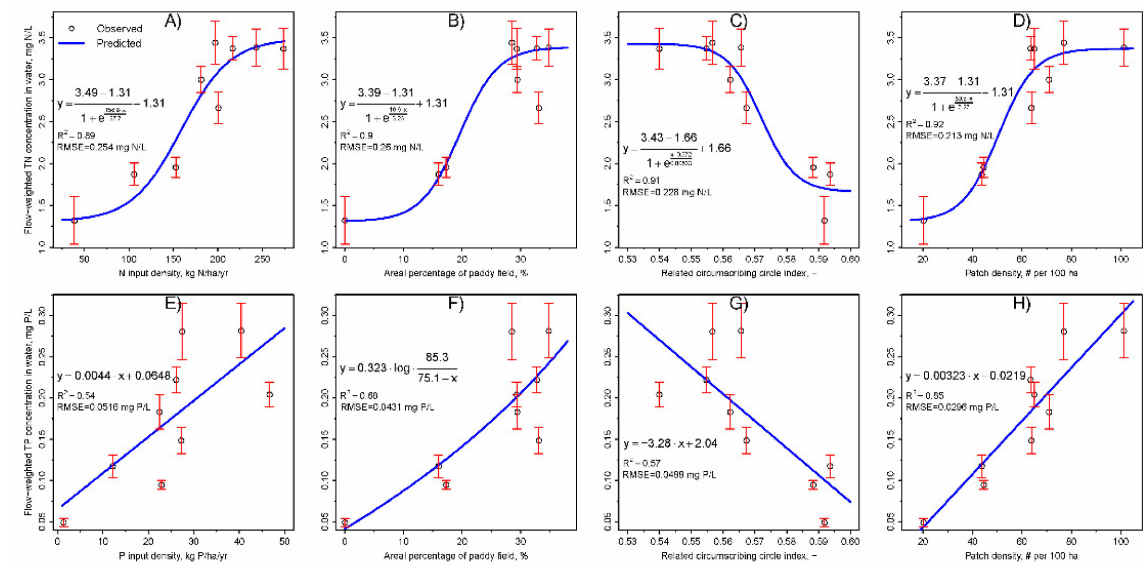
Figure 3. Relationships of the flow-weighted total nitrogen (TN) and total phosphorus (TP) concen- trations in outlet water with the N and P input densities ( A , E ), the areal percentage of paddy field ( B , F ), the related circumscribing index ( C , G ) and the patch density ( D , H ) in the nine catchments. The blue lines are the model fitting curves. The bars denote the standard errors of the observed 6-year flow-weighted TN and TP